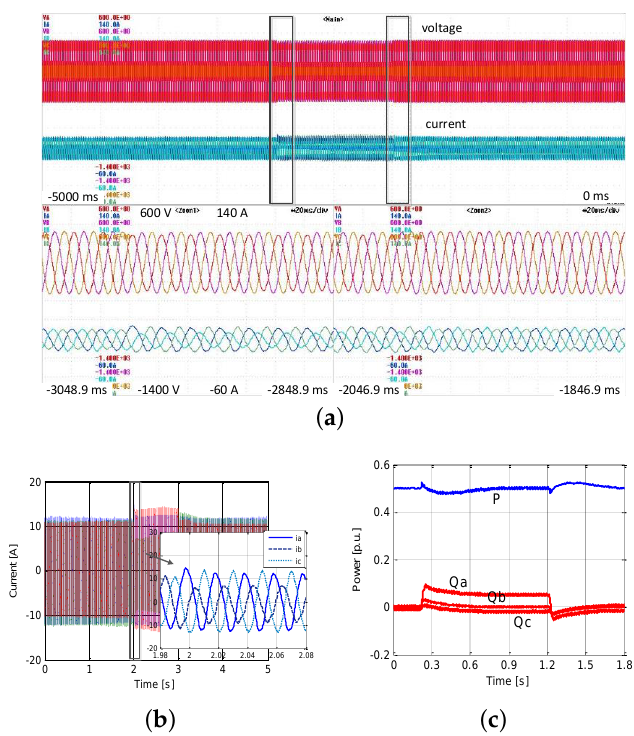
Figure 16. Experimental results of the SPC under unbalanced voltage sag: ( a ) grid voltage and injected current; ( b ) injected current; and ( c ) total active power and reactive power in each